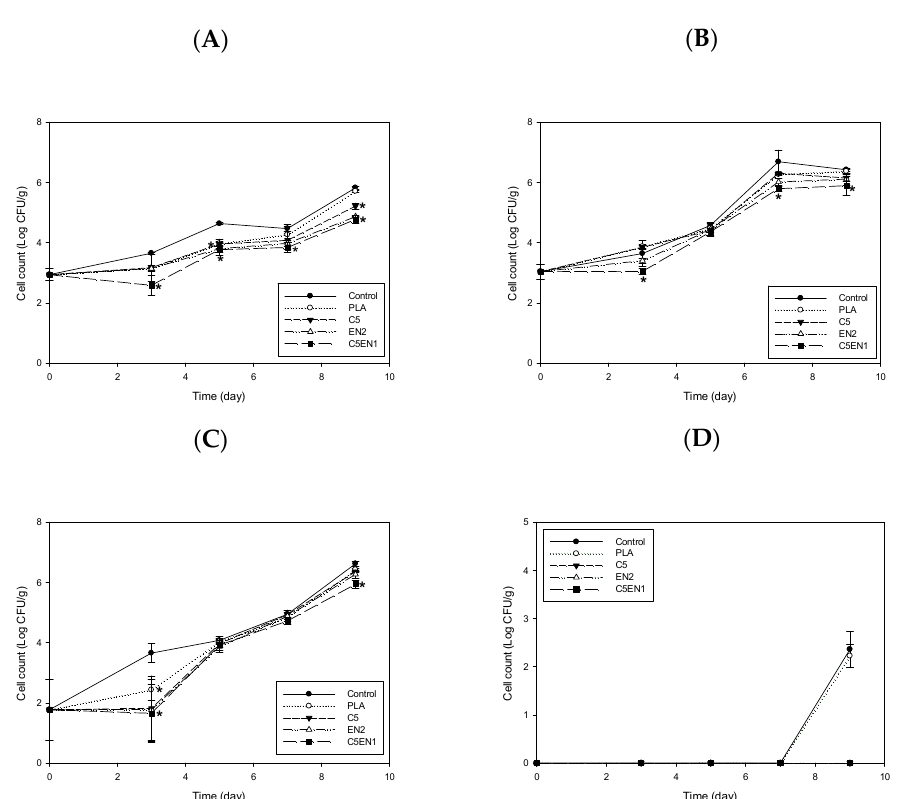
Figure 7. Changes in cell counts of Escherichia ( A ), Aeromonas ( B ), Pseudomonas ( C ), Vibrio ( D ) in fish fillet ( Epinephelus fuscoguttatus × Epinephelus lanceolatus ) covered with PLA, C5, EN2, or C5EN1 film during storage at 4 °C. PLA, PLA film as control; C5, PLA + 0.5% chitosan; EN2, PLA + 20 mM EDTA + 0.02% nisin; C5EN1, PLA + 0.5%chitosan + 20 mM EDTA+0.01% nisin. Data are presented as mean ± SD (n = 3). * means significantly different, compared to control ( p < 0.05).